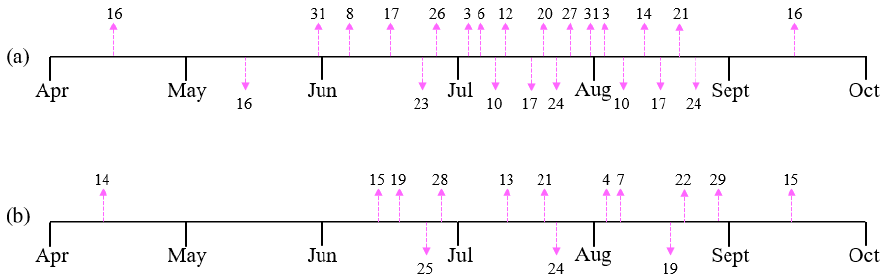
Figure 4. The sampling dates in 2020 ( a ) and 2021 ( b ) seasons.